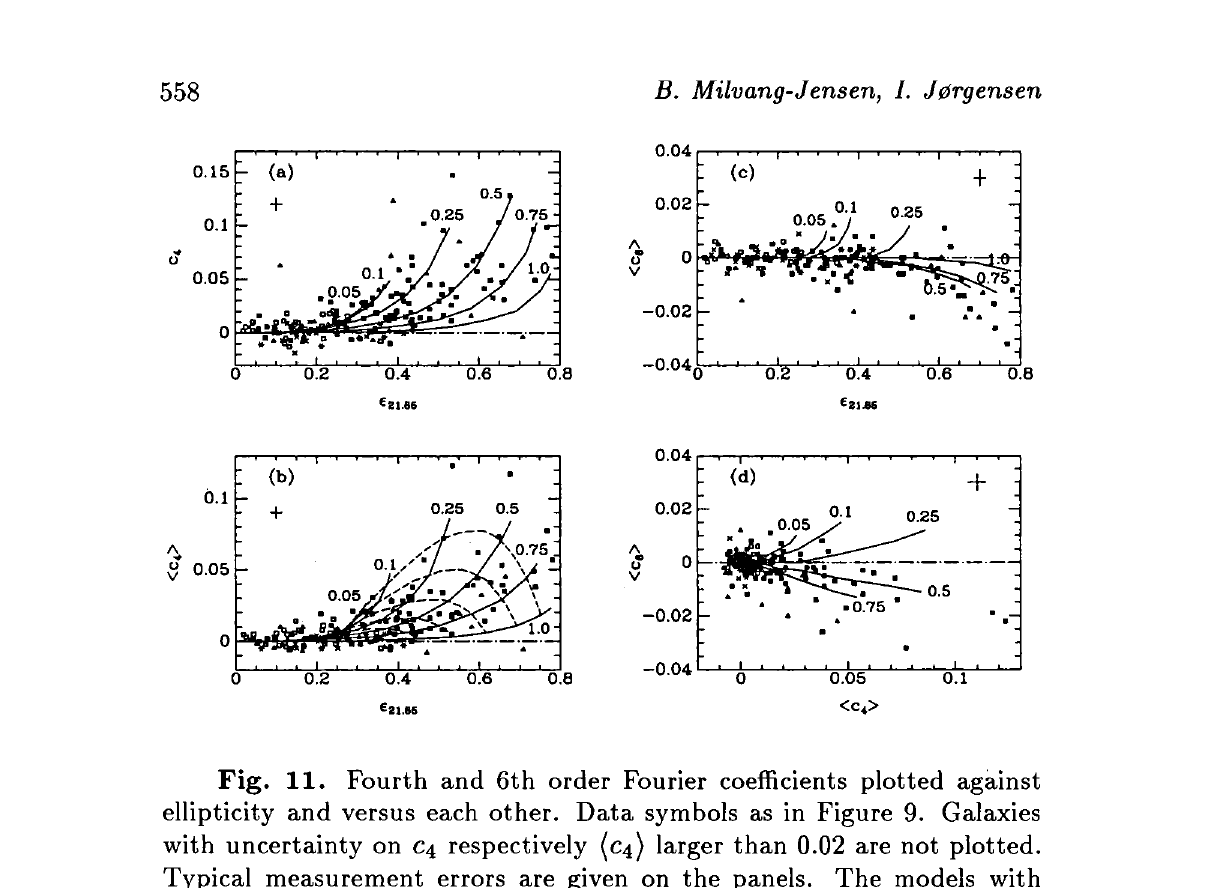
Fig. 11. Fourth and 6th order Fourier coefficients plotted against ellipticity and versus each other. Data symbols as in Figure 9. Galaxies with uncertainty on C4 respectively (C4) larger than 0.02 are not plotted. Typical measurement errors are given on the panels. The models with a eB = a eD a re overplotted. The curves are labeled with Lj^/Ltot- The dashed lines on (b) mark the inclinations where cosi = 0.1, 0.2, 0.3, 0.4 and 0.5 (i.e. i = 84°, 78°, 73°, 66°, and 60°), from top to bottom. No dashed line is shown for the i = 90° (i.e. edge-on) models, but this line would be above the i = 84° dashed line, connecting the end points of the solid lines. It is seen that for a given Ln/Ltot the highest inclination gives the largest (C4). The non-zero coefficients for the pure disk-model are due to the inclusion of seeing effects in the models. (From